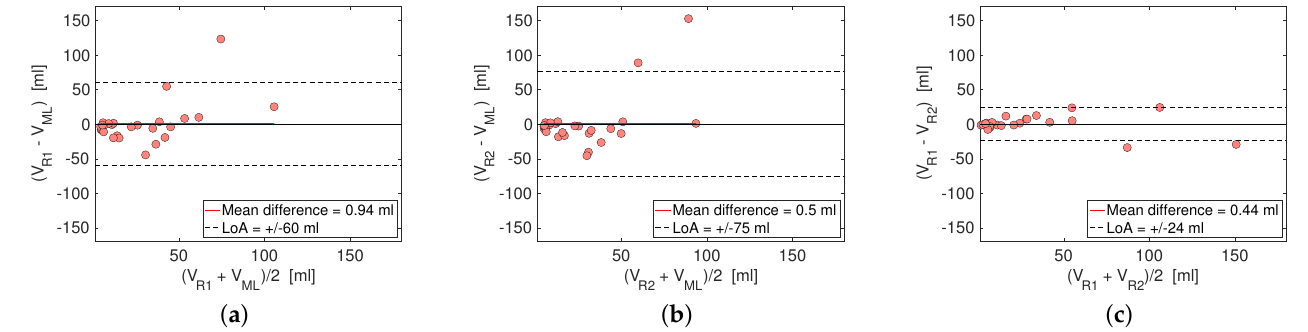
Figure 6. Bland–Altman plots comparing tumor volumes V [mL] from ( a ) DL (deep learning) and R1, ( b ) DL and R2 and ( c ) R1 and R2. Red lines indicate mean difference of the estimate, and dashed lines represent lower and upper limits-of-agreement (LoA). Mean difference in estimated tumor volumes is low for all comparisons, indicating a high agreement in mean primary tumor volume by all methods. However, LoA is higher for DL-R1/R2 than for R1-R2, indicating a higher individual disagreement for tumor measurements by DL-R1/R2 than by R1-R2. R1 = rater 1; R2 = rater